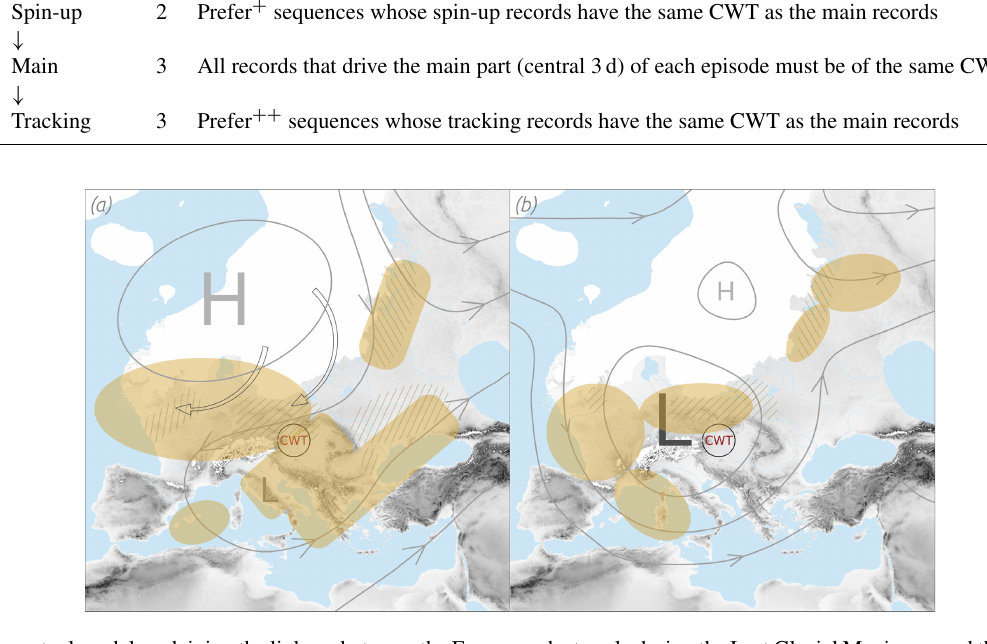
Figure 2. Conceptual model explaining the linkage between the European dust cycle during the Last Glacial Maximum and the loess deposits. The main dust deposition areas (filled), emission areas (hatched), and wind (grey lines) and pressure patterns (H or L: high or low pressure) are highlighted; all of them result from the WRF-Chem-LGM experiments. The centre of the region for the circulation weather type analysis is denoted by CWT. (a) Northeasters, easterlies, and southeasters (the east sector winds; transparent arrows with black perimeter) caused by the semi-permanent high pressure over the Eurasian ice sheet (white) prevailed 36% of the time over central Europe (Table 2). (b) The cyclonic weather type regimes which prevailed 22% of the time over central Europe (Table